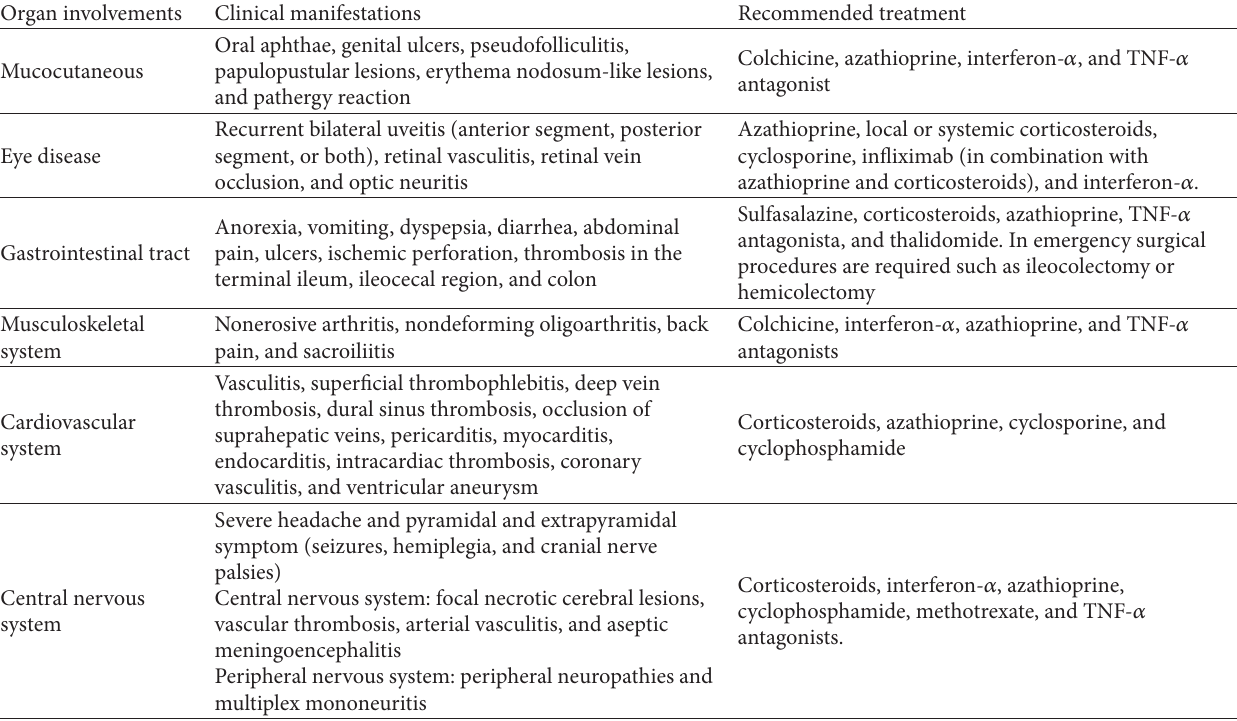
Table 1: Brief summary of the main clinical manifestations of Behc¸et’s